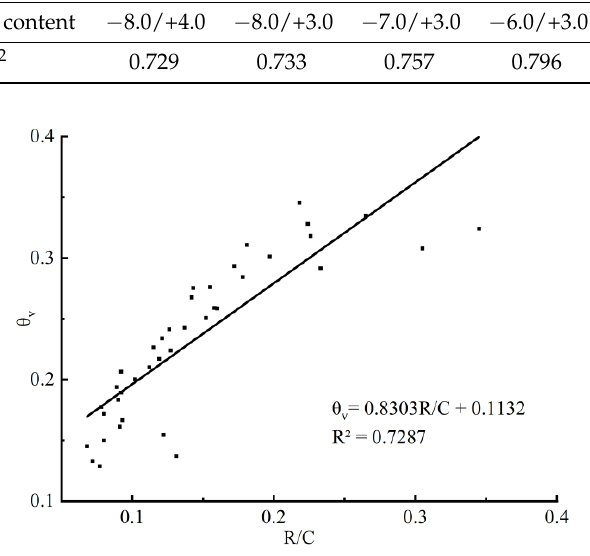
Figure 5. θ v – R/C calibration equation (B1 group). Figure 5. θ v -R/C calibration equation (B1 group).